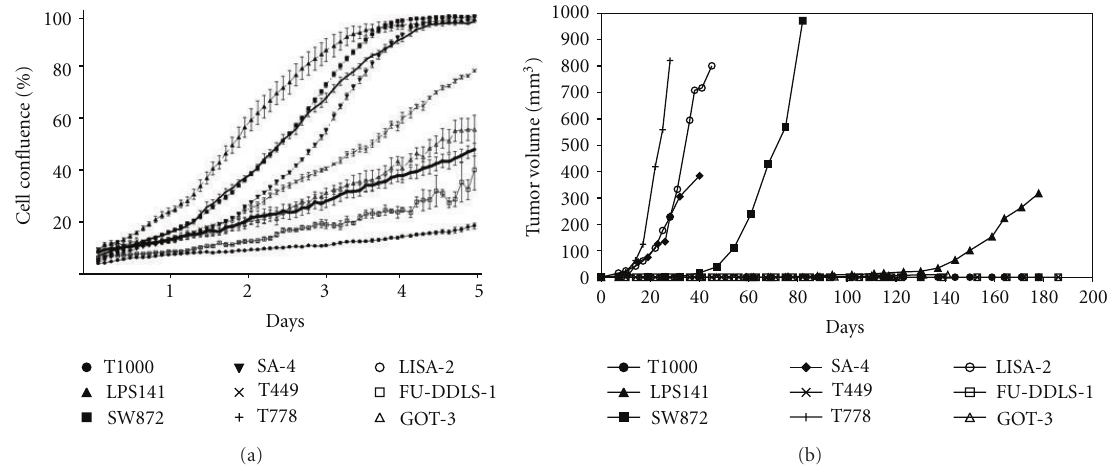
Figure 1: Proliferation capacity and tumor-forming ability of the LPS cell lines. (a) The proliferative capacity was determined by live cell imaging (cell confluence versus time). (b) Tumor formation was determined by injecting 1 × 10 6 cells into NOD-SCID mice and measuring growth over a 6-month period.